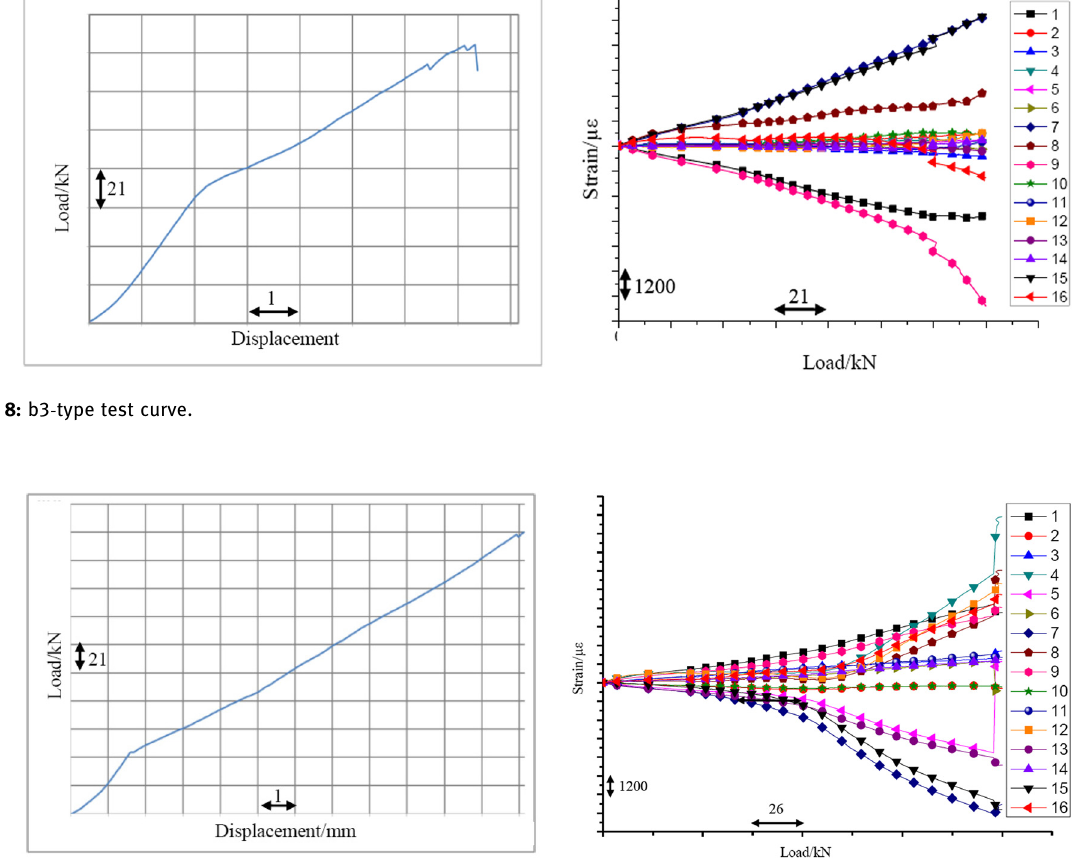
Figure 9: c1 - type test curve.